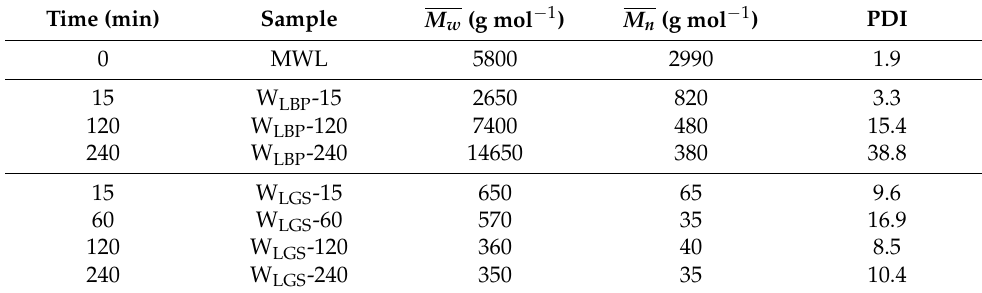
Table 4. Weight-average molecular weight ( M w ), number-average molecular weight ( M n ) and polydispersity index (PDI) of the MWL (used as reference), W LBP and W LGS samples with time of